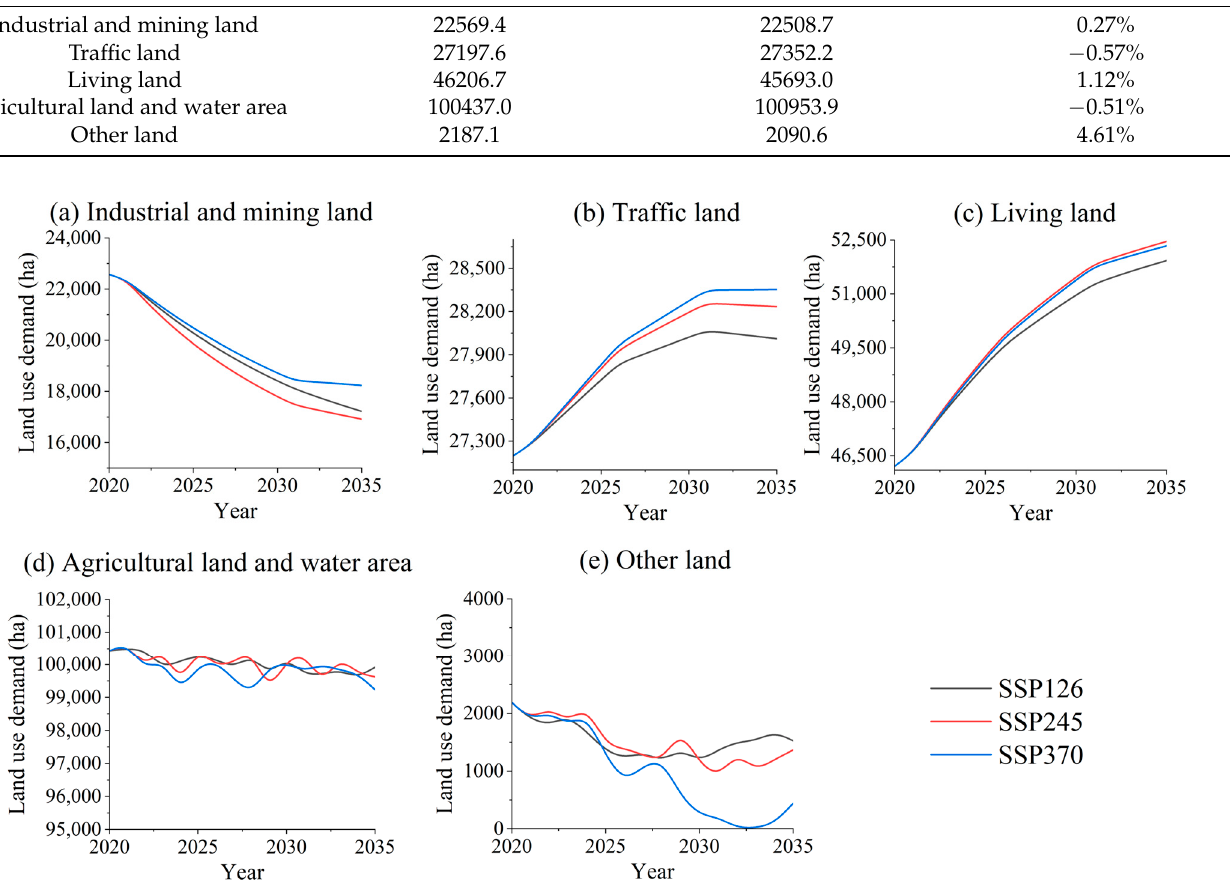
Figure 4. Trajectories of demand for each land use type from 2020 to 2035 under SSP-RCP scenarios: